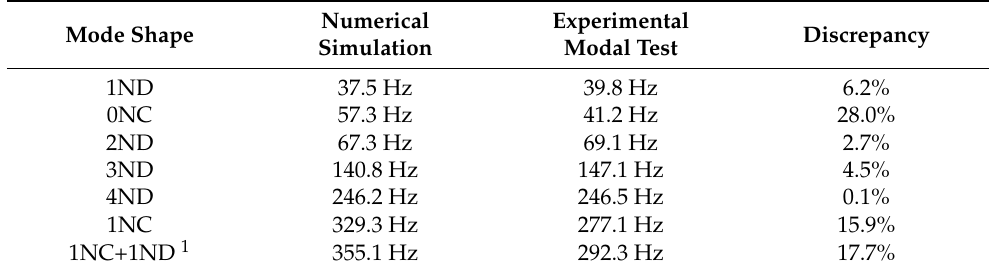
Table 1. Natural frequencies obtained from numerical and experimental modal analyses of the non-rotating disk in air. Numerical Experimental Discrepancy Mode Shape Simulation Modal Test 1ND 37.5 Hz 39.8 Hz 6.2% 0NC 57.3 Hz 41.2 Hz 28.0% 67.3 Hz 69.1